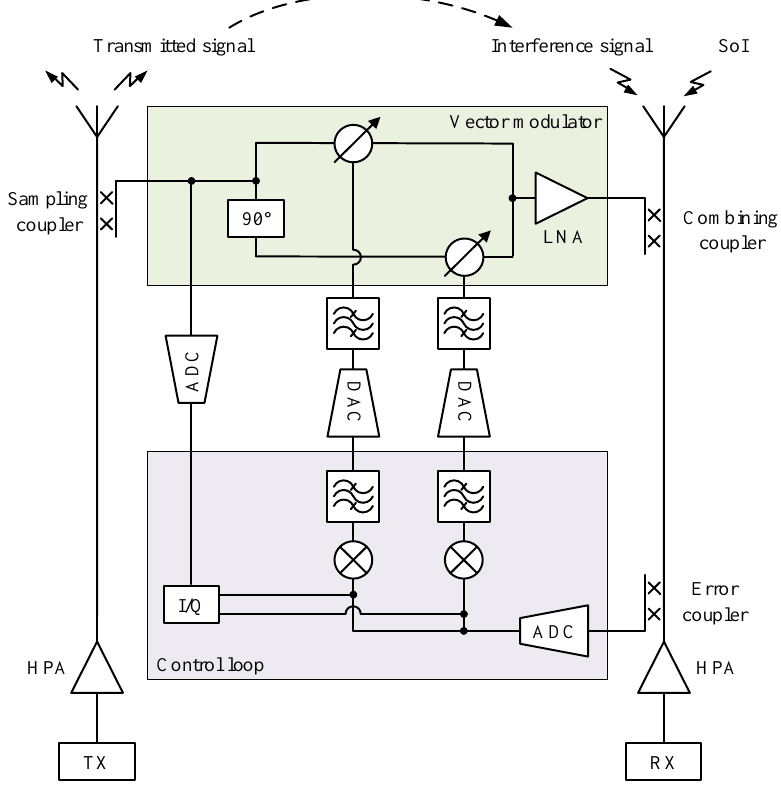
Figure 8. A typical analog–digital hybrid SIC topology.